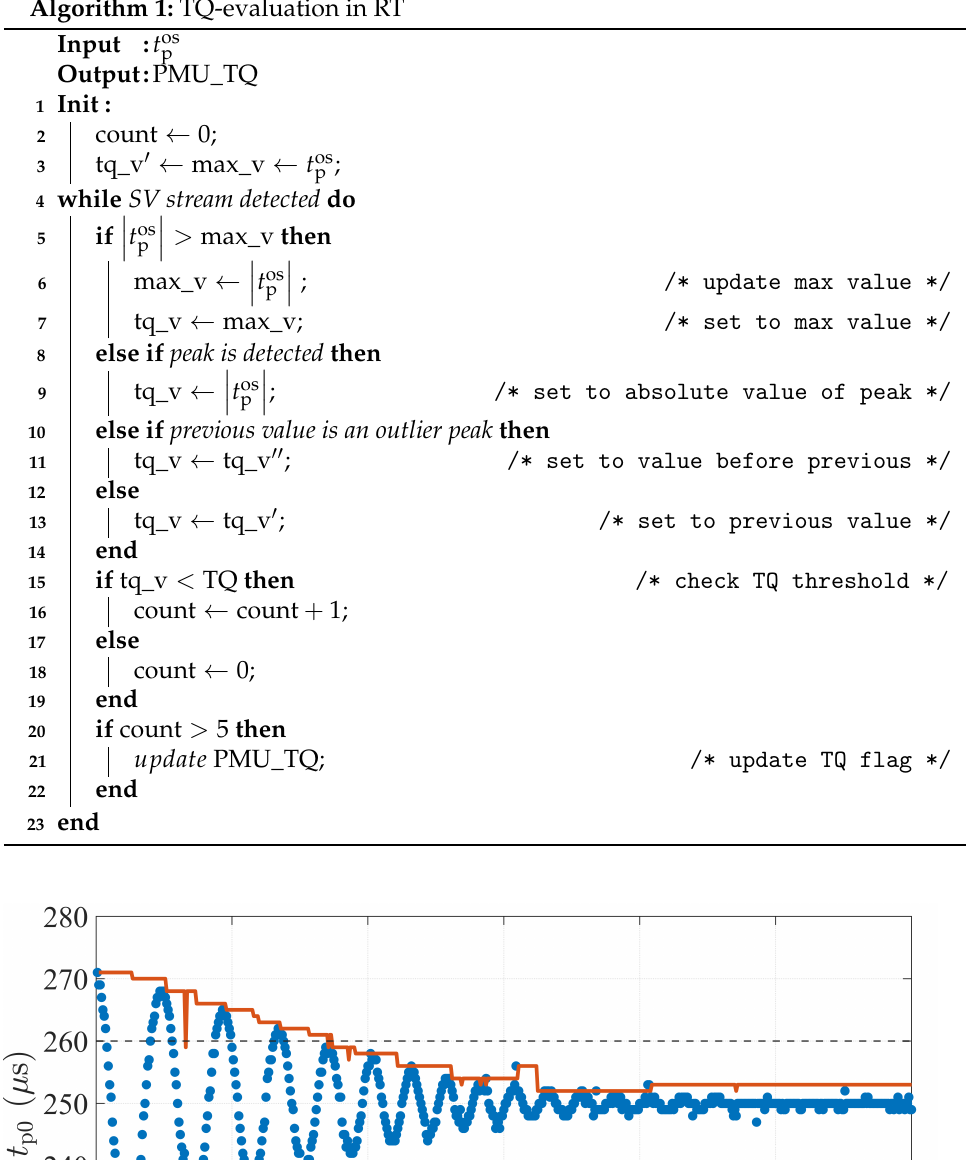
Algorithm 1: TQ-evaluation in RT